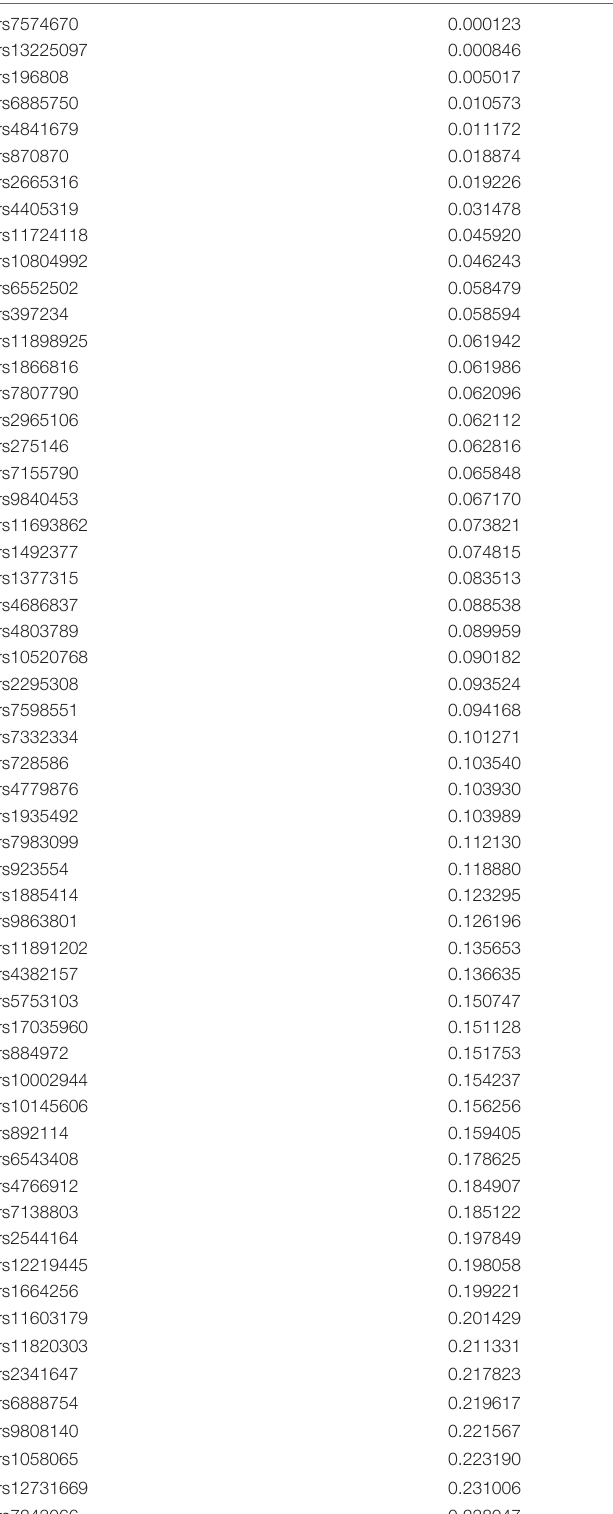
TABLE 2 | The Snack Delay Task was performed at 36 months in the children from the MAVAN cohort. Snack Delay – Test